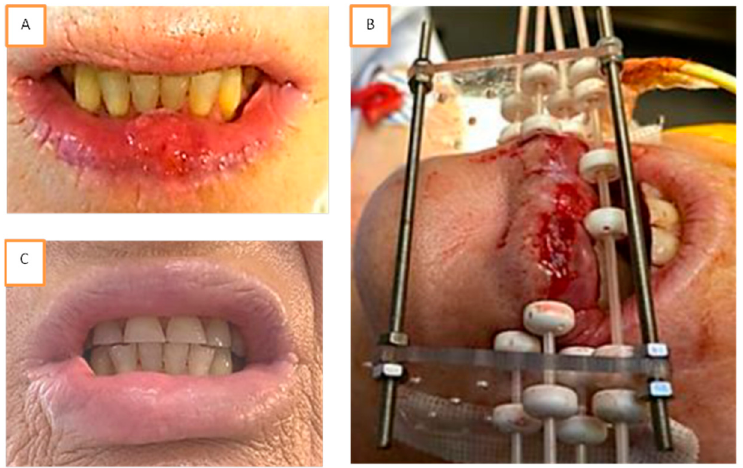
Figure 1. Example of brachytherapy implantation for a T1 N0 squamous cell carcinoma of the inferior lip. Tumor was measured at 18 × 15 mm² and localized in the mid lip ( A ). Implantation was performed following Paris system rules with two planes. Four needles were used, including one needle in plesiotherapy to increase the dose at the level of the tumor ( B ). The patient experienced acute reaction with radiomucitis grade II at week 6. At week 23, complete response was achieved with disappearance of all acute reactions and without any sequalae ( C ).